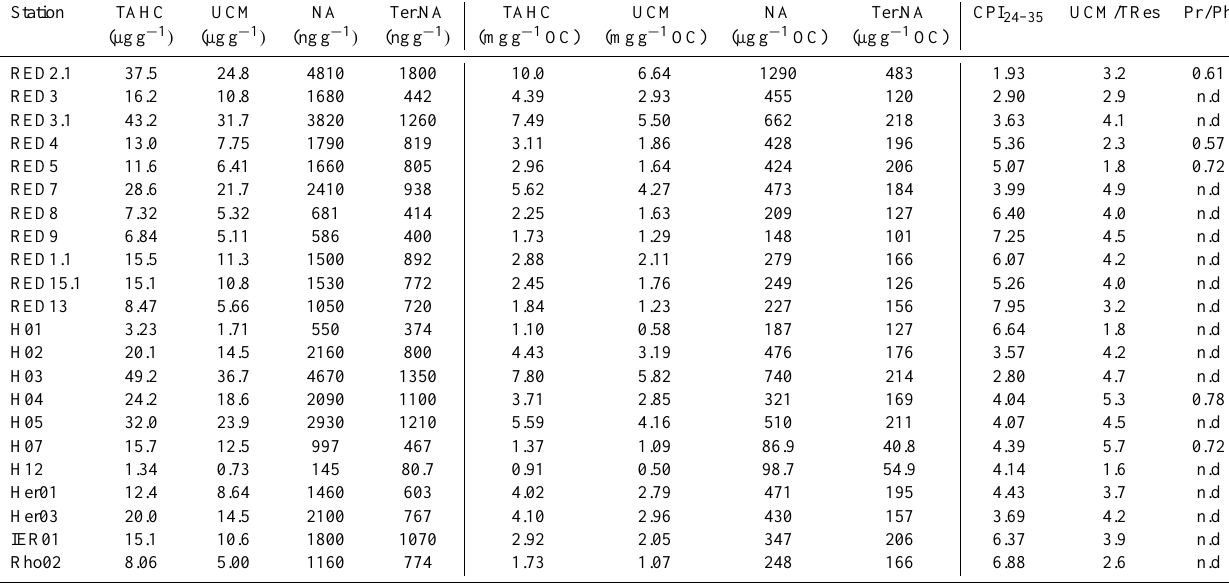
Table 2. Concentrations (per dry weight and OC-normalized) and characteristic parameters of aliphatic hydrocarbons determined in deep-sea sediments of the eastern Mediterranean